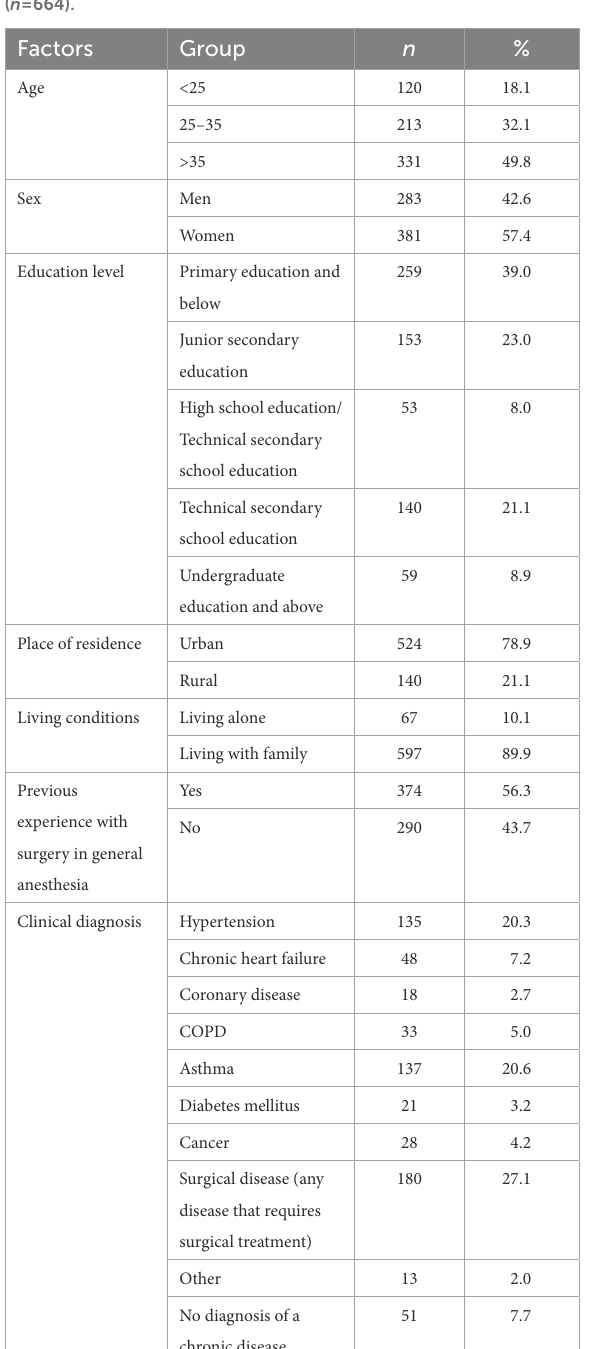
TABLE 2 Factor loadings of exploratory factor analysis for the Chinese version of the FH scale.